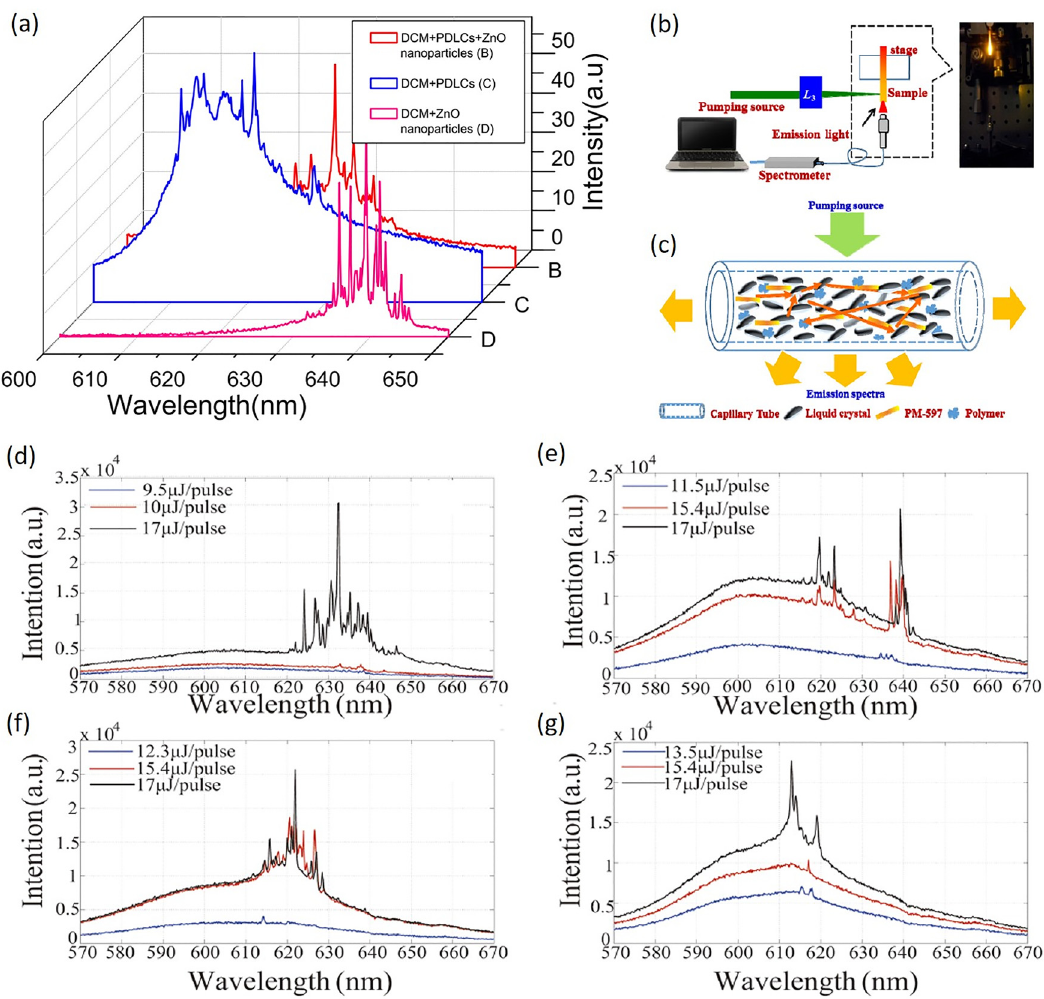
Figure13: EmissionspectraofDCM + PDLCs + ZnOnanoparticles(b),DCM + PDLCs,(c)andDCM + ZnOnanoparticles(d),respectively,excited by the pump energy above threshold [131] (a). Schematic illustration of the experimental setup of the random laser from the capillary tube in fi lling of the DD-PDLCsand photograph showed onthe right (b), and the descriptionof the multiplerecurrent light scattering in the capillary tubecomprisedoftherandomalignmentofLCs,monomer(NOA65),andlaserdye(PM597)[132](c).Thespectraofrandomlasingfromsamples with MNP doping concentration of 0 wt.% (d), 0.01 wt.% (e), 0.02 wt.% (f), and 0.03 wt.% (g) in the PDLC with various pump energies